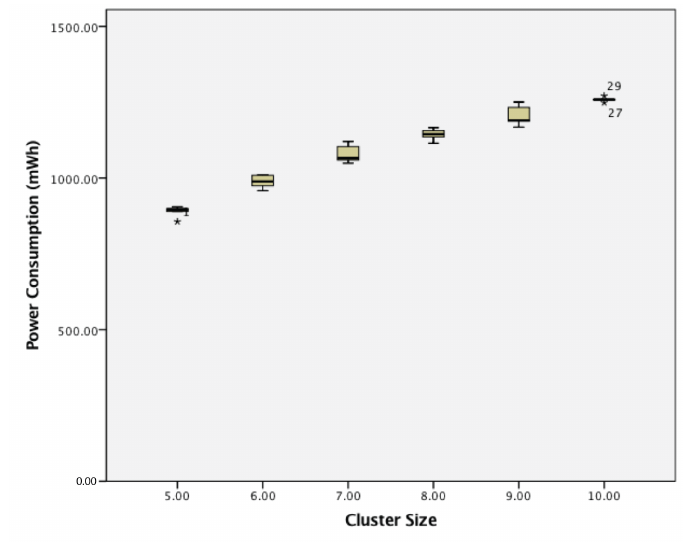
Figure 13. Power consumption of cluster of 5–10 passive wireless sensor nodes with a 5 s transmission